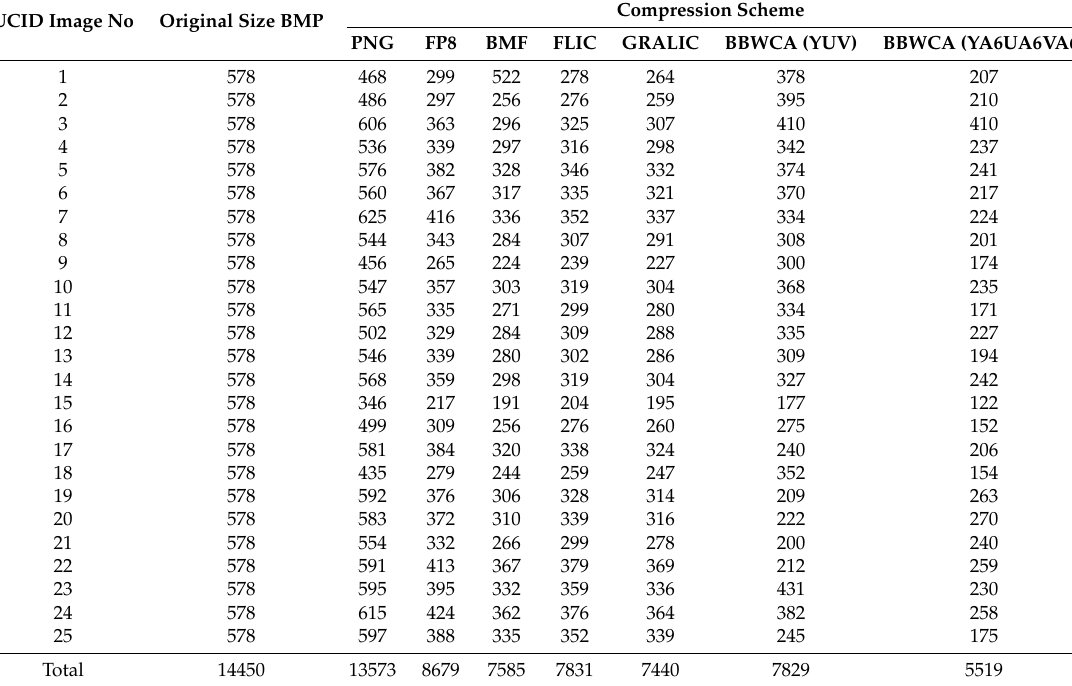
Figure 5. University of Loughborough - UCID Outdoor Images. Table 3. Comparison of compression sizes for UCID outdoor